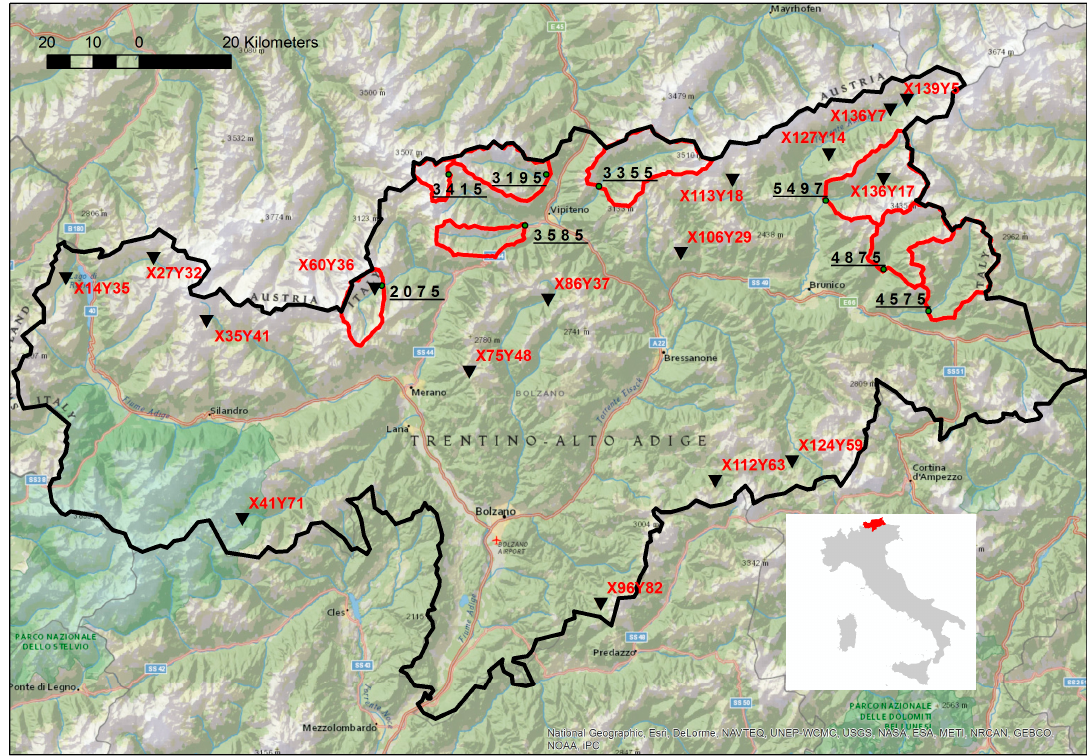
Figure 1. Study area with indication of the available snow depth measurement stations (triangles, codes in red) and discharge measurement stations used to test snowmelt (dots, codes underlined in black), with the respective catchments (red outlines).